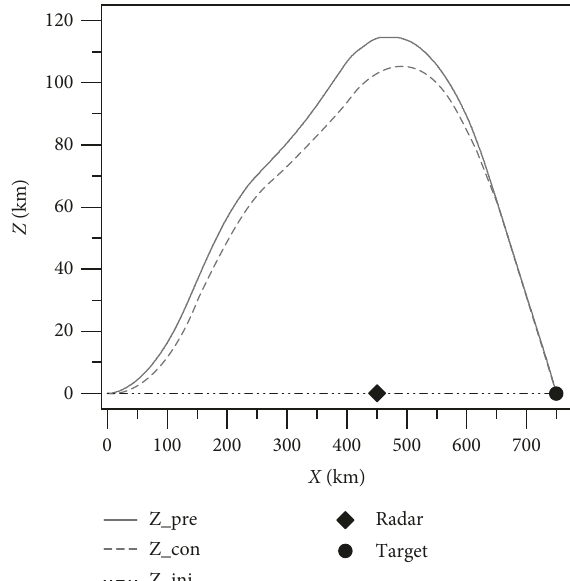
Figure 11: Lateral trajectory before and after